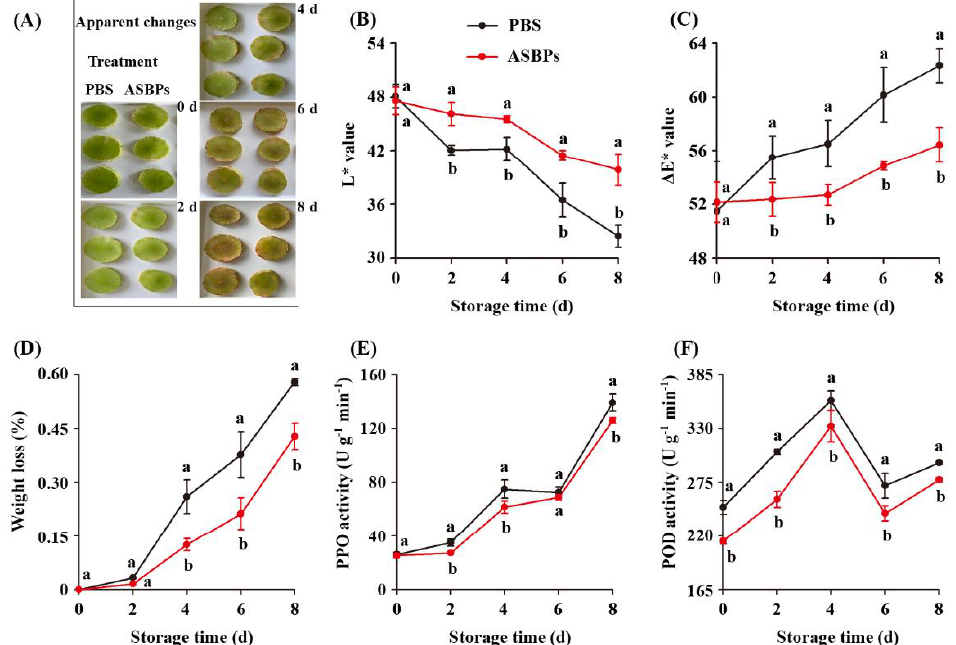
Figure 10. Effect of ASBPs treatment on the visual appearance ( A ), chromaticity L* ( B ), ∆E ( C ), wight loss ( D ), PPO ( E ) and POD ( F ) activities of fresh-cut asparagus lettuce slices during storage at 4 °C for 8 days. Different letters indicate significant differences between groups at each of the sampling timepoints ( p < 0.05).